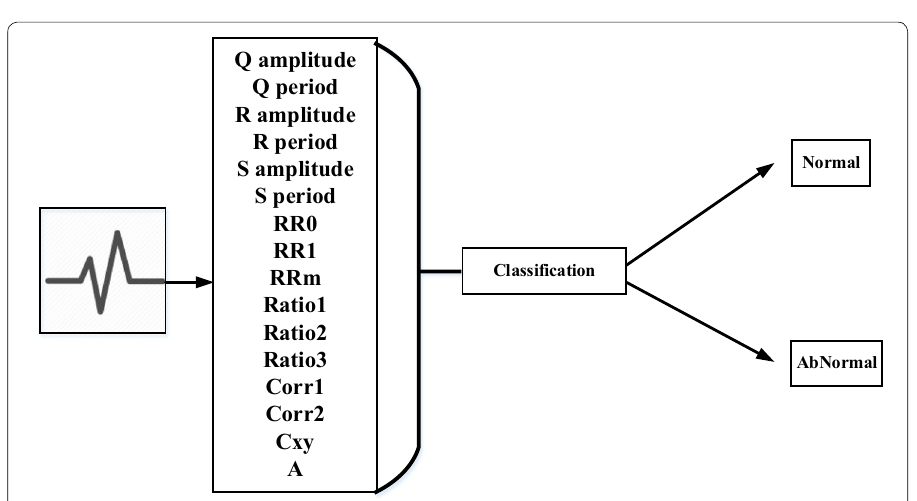
Fig. 6 Total features for